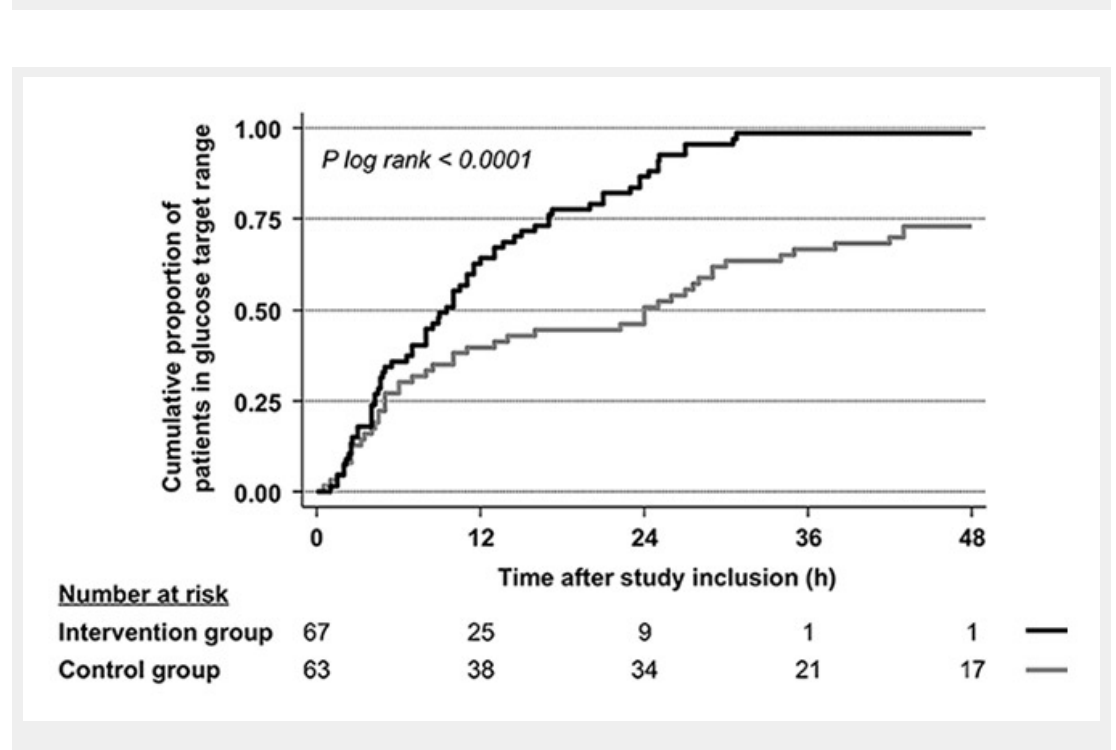
Figure 4 Cumulative proportion of patients in the two groups reaching the glucose target range after inclusion in the